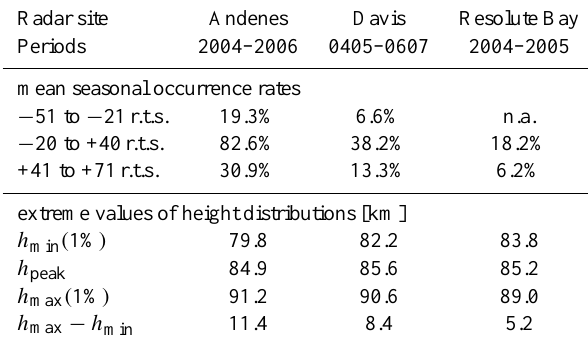
Table 4. Comparison of mean PMSE occurrences for different pe- riods of the year relative to solstice (r.t.s.) and extreme values of PMSE height distributions at Andenes, Davis and Resolute